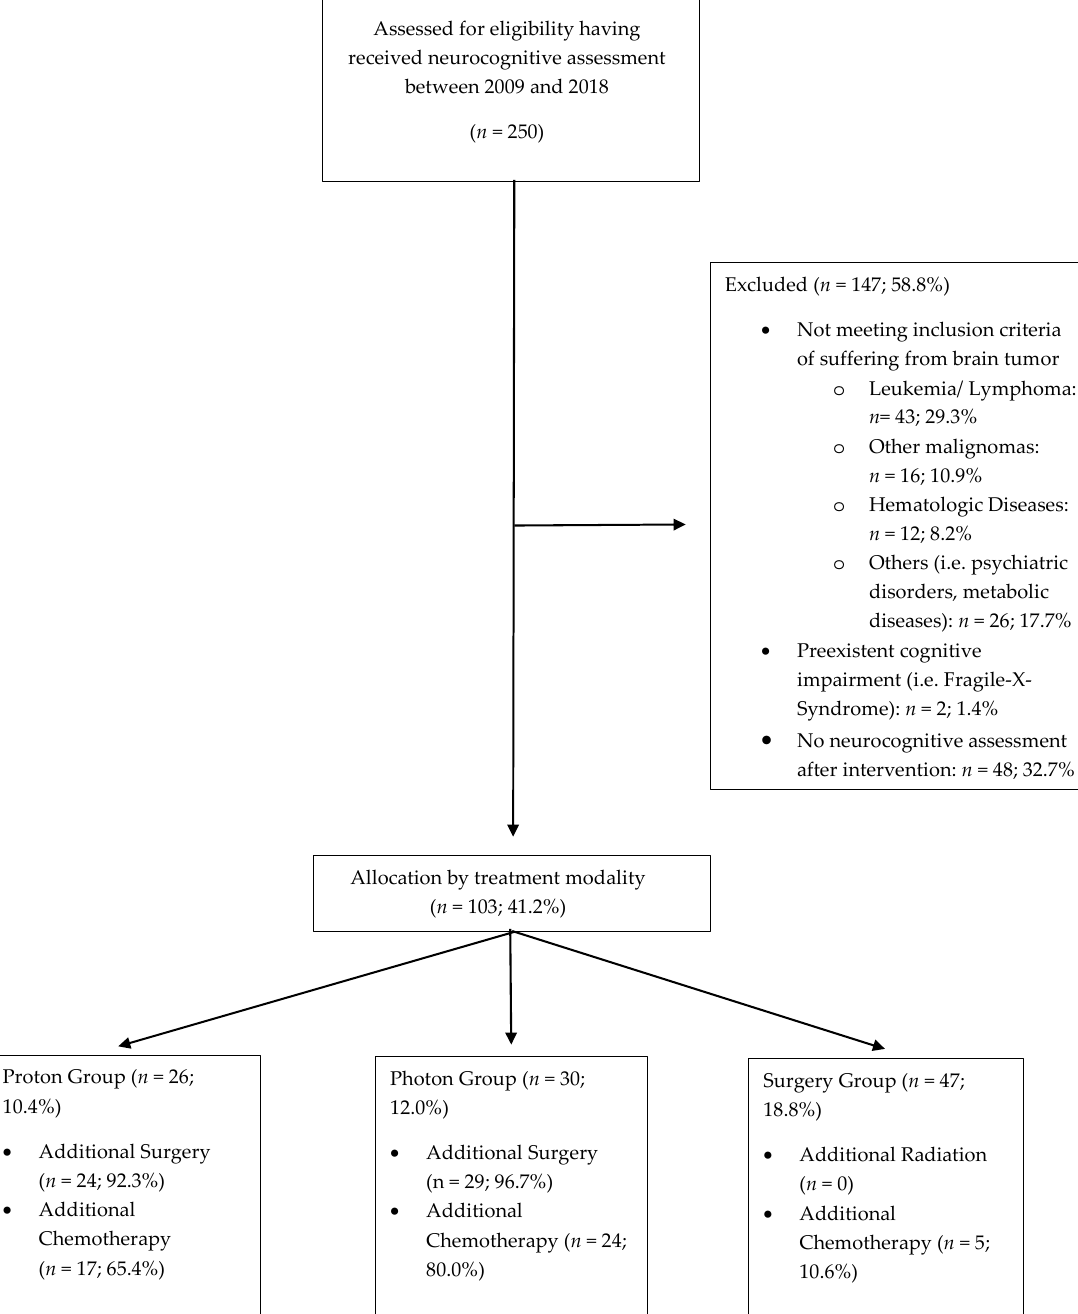
Figure 1. Consort Diagram: Neurocognitive Assessment of Pediatric Brain Tumor Patients.